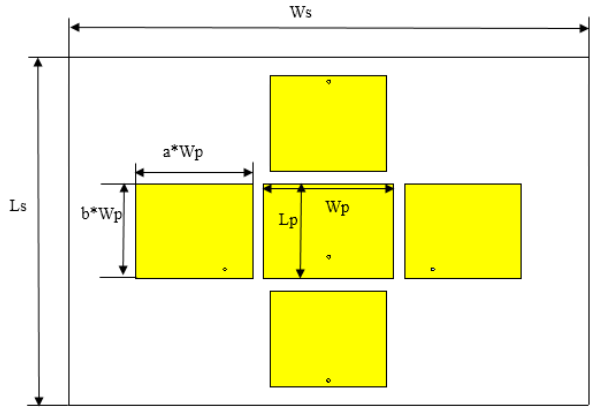
Figure 1. The geometry of the proposed structure.